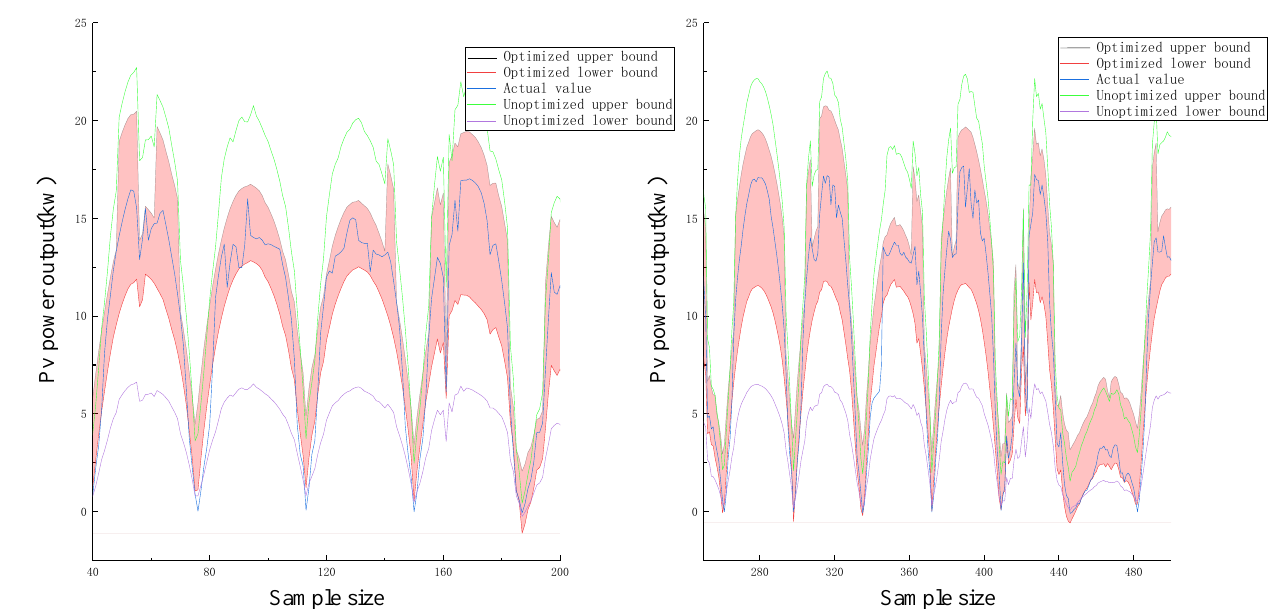
Figure 12. Comparison of power stations 1 and 2.